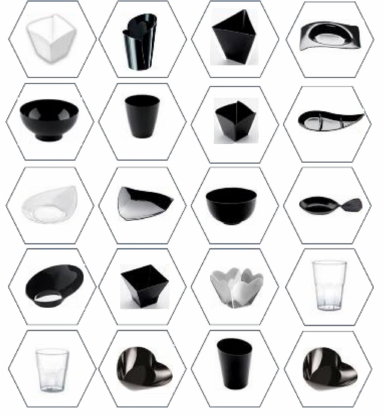
Figure 11. Finger food products.